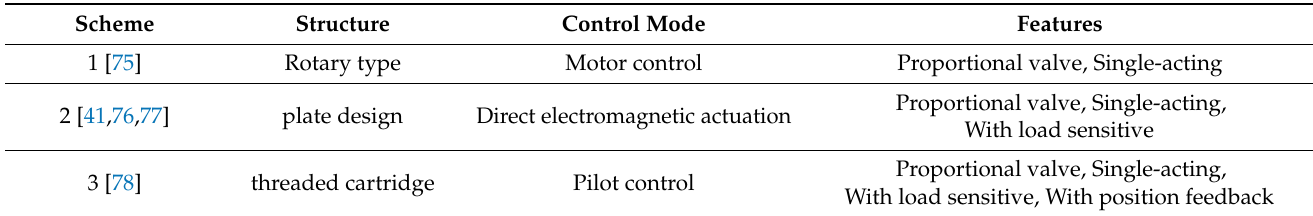
Table 4. Comparison of the hydraulic control valves with different